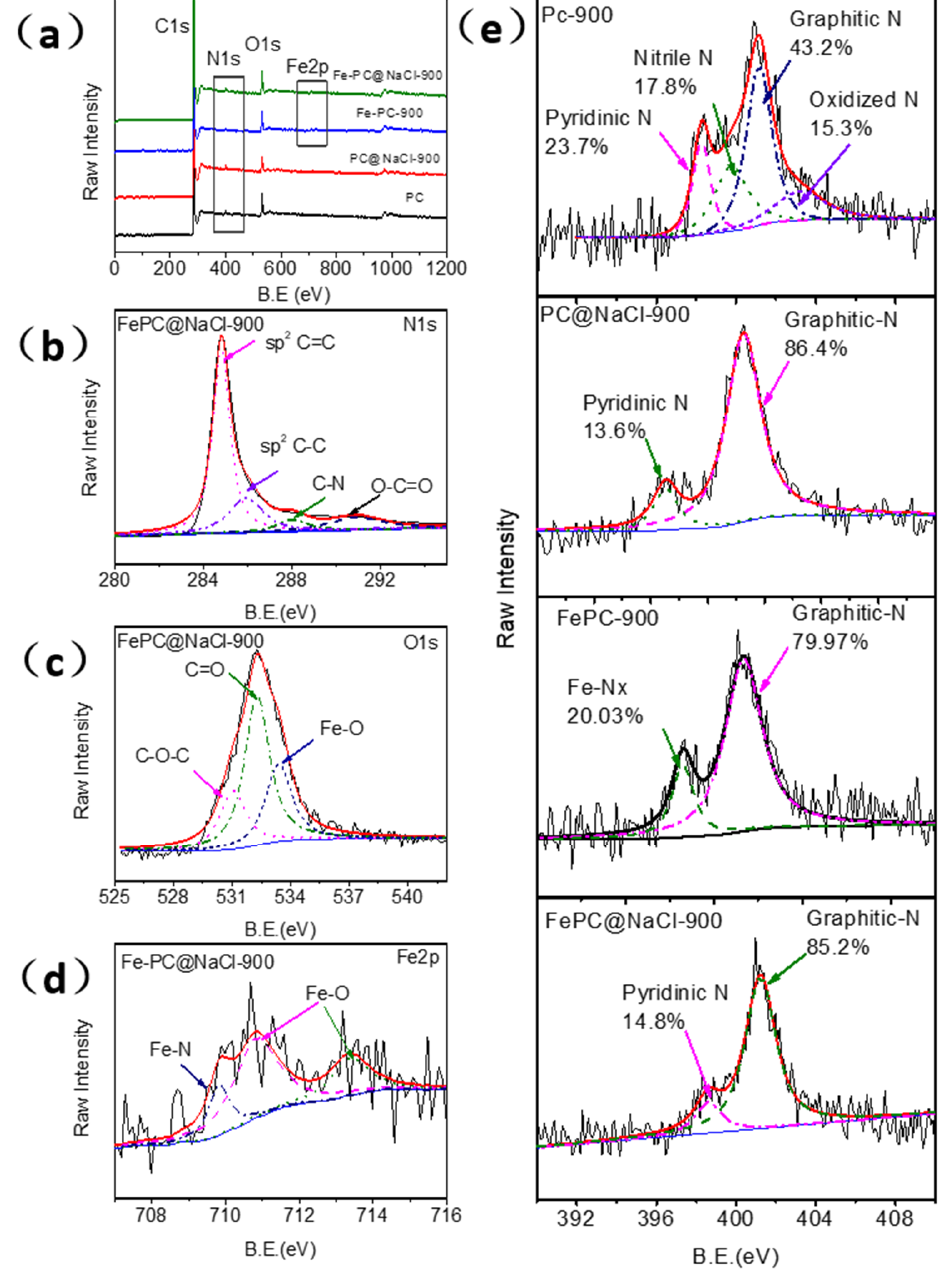
Figure 4. ( a ) XPS full-scan spectra of the PC material, PC@NaCl-900, FePC-900, and FePC@NaCl- 900. ( b – d ) High-resolution C1s, O1s, and Fe 2p XP narrow-scan spectra of FePC@NaCl-900. ( e ) High-